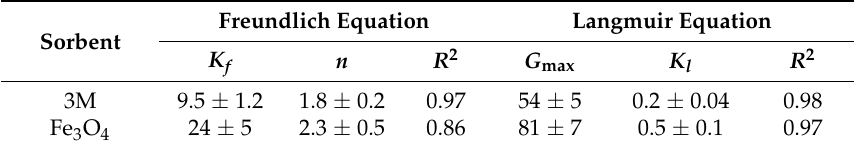
Table 2. Parameters of Freundlich and Langmuir equations for the isotherms of Sr 2+ sorption on virgin Fe 3 O 4 and the magnetic composite 3M.